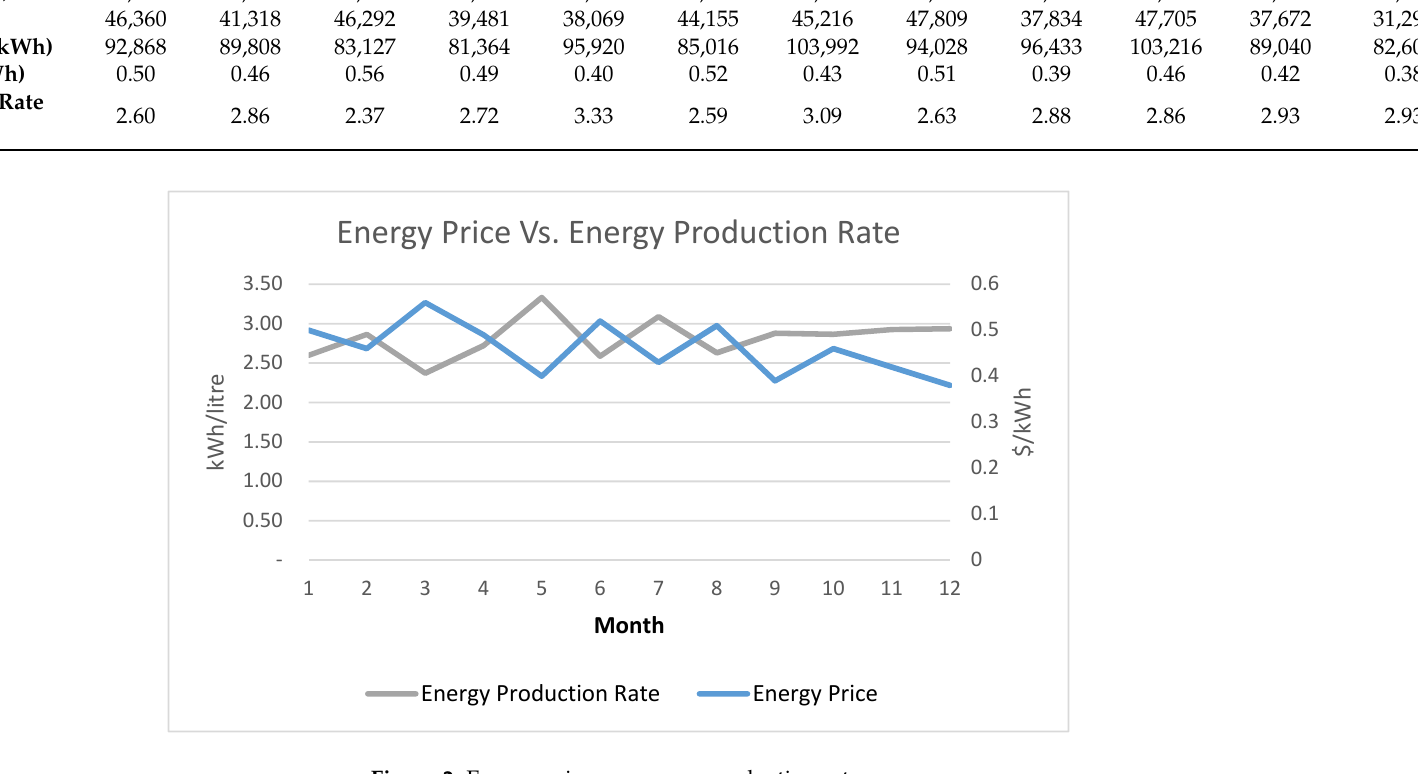
Figure 2. Energy price vs. energy production rate .